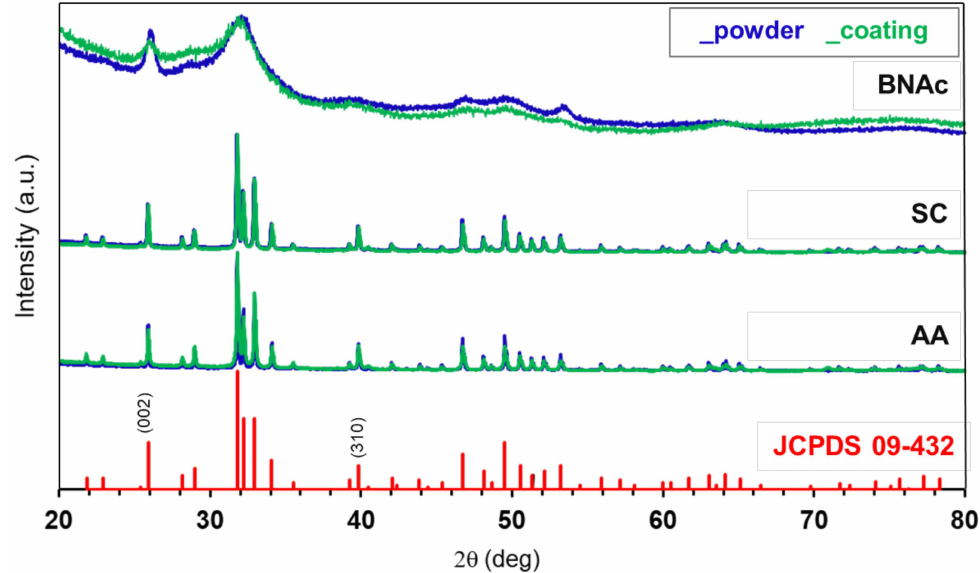
Figure 5. XRD analysis: comparison between powders and coatings